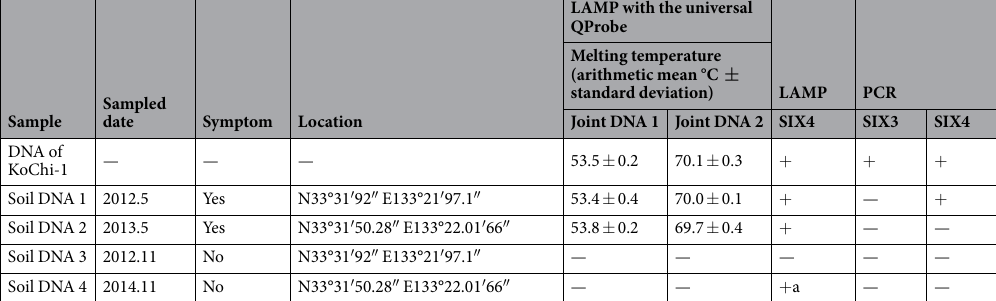
Table 3. Comparison of molecular detection for Fol race 3 from field soil of Kochi prefecture. + , detection − , no detection a, LAMP products were obtained only once in three